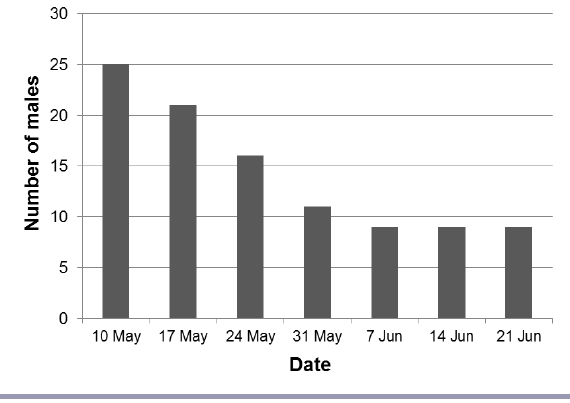
Fig. 3 . Changes in the number of territorial Black- headed Bunting ( Emberiza melanocephala ) males in the study plot during May and June 2013.